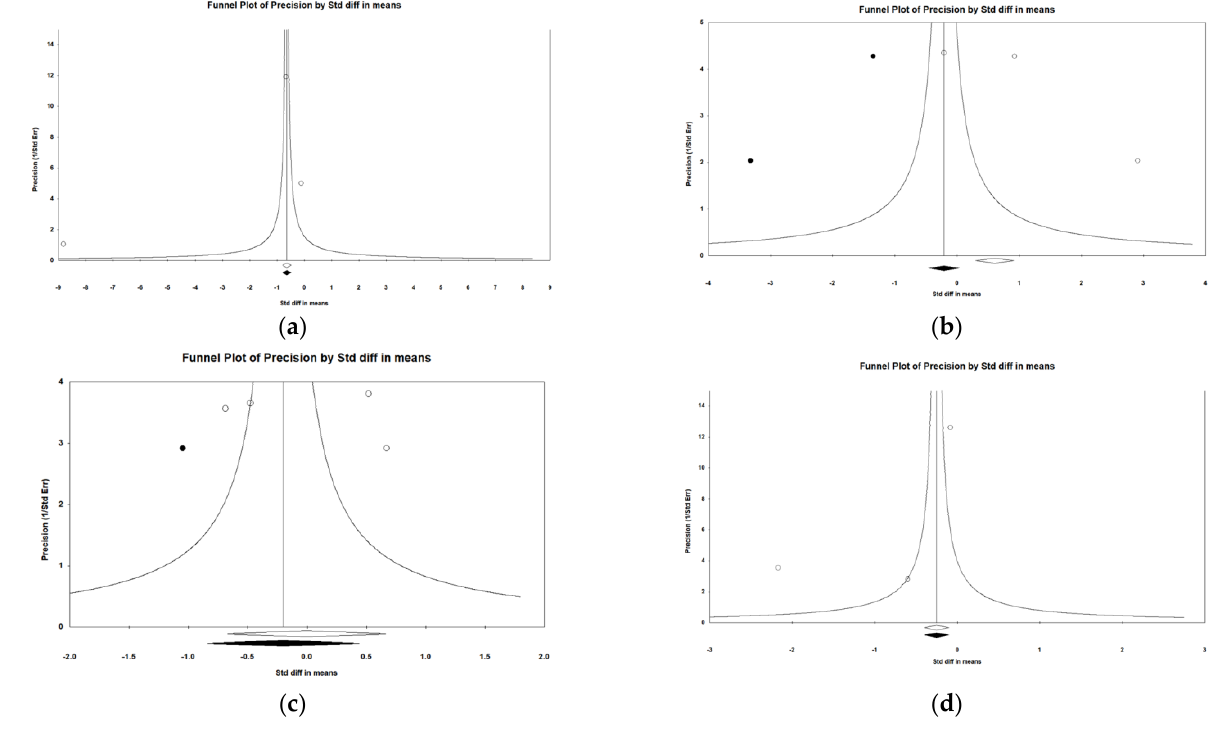
Figure 8. Funnel plots. ( a ) DBP; ( b ) EEG α waves; ( c ) attention; ( d ) response time. Table 20. Results of linear Egger’s regressions test.